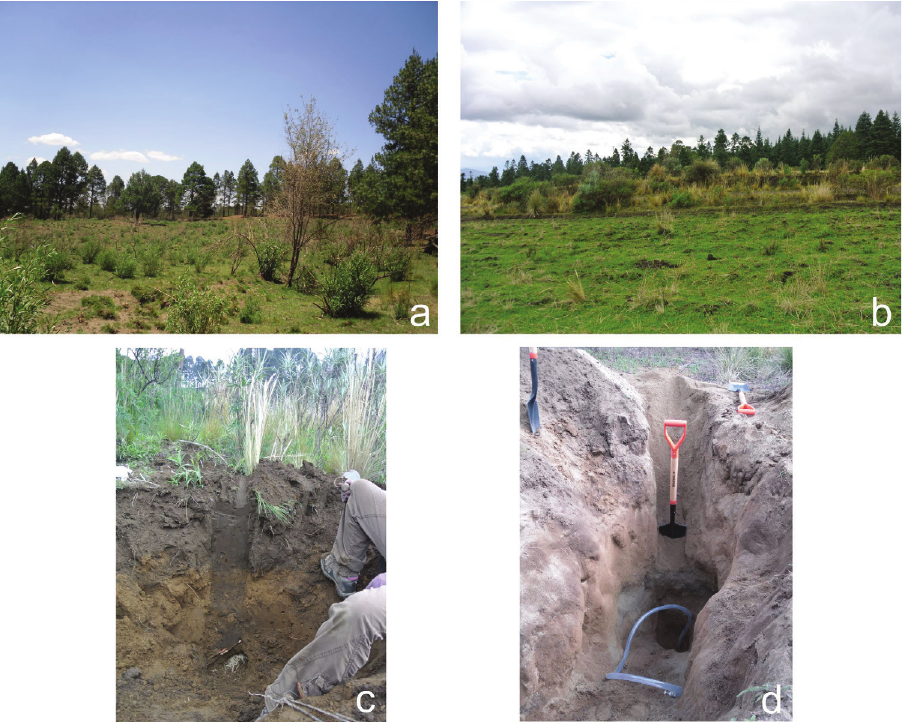
Figure 2. Example of the biotopes where the pocket gophers’ burrows were dug: a scrubland in Malinche b grassland in Sierra Negra c pocket gopher nest at 50 cm depth d pocket gopher nest at more than 1.6 m